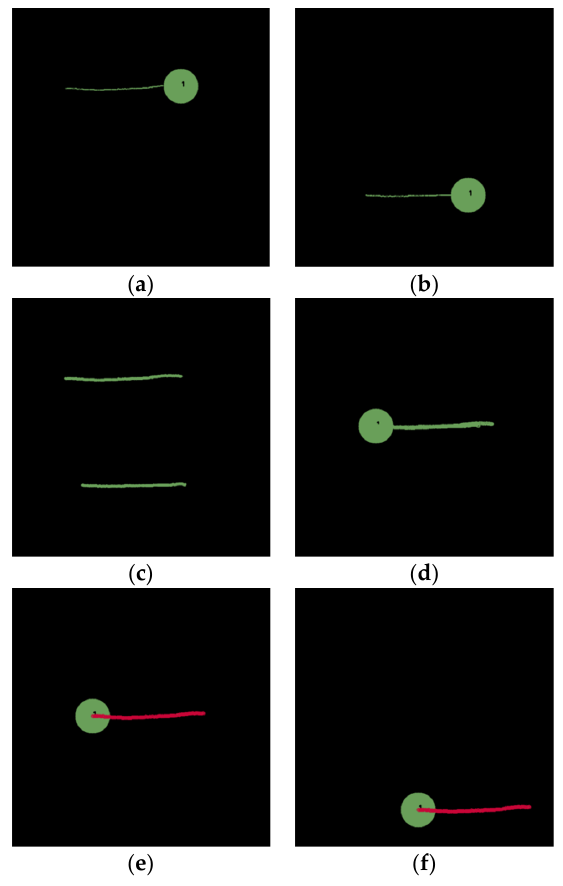
Figure 6. ‘Push’ a green circle to the right side. ( a ) The first demonstration path. ( b ) The second demonstration path. ( c ) Absolute trajectory (type-1) through two demonstrations. ( d ) Relative trajectory (type-2) through two demonstrations. ( e ) Key path of the relative trajectory (type-2). ( f ) Planned path based on the key path.